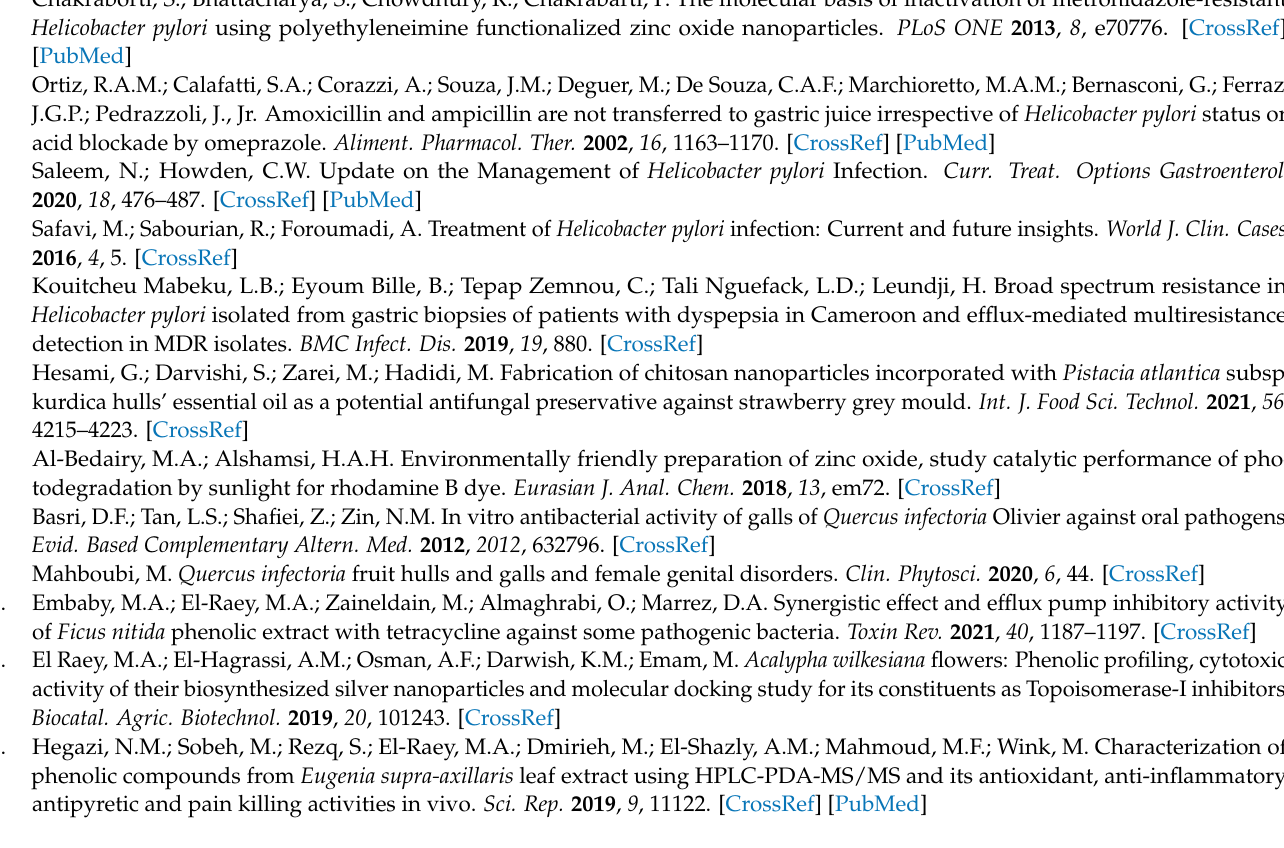
Figure S2: Zeta sizer diagram (A) and zeta potential diagram (B) of